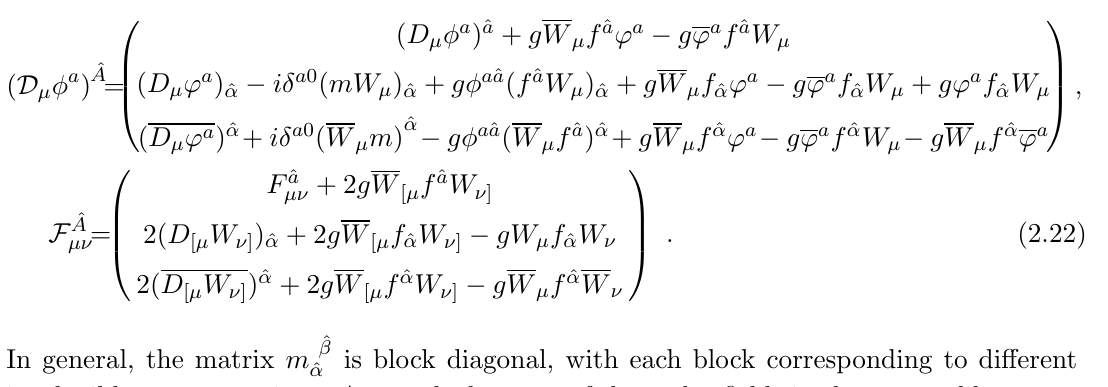
( (cid:30) a ) (cid:22) D